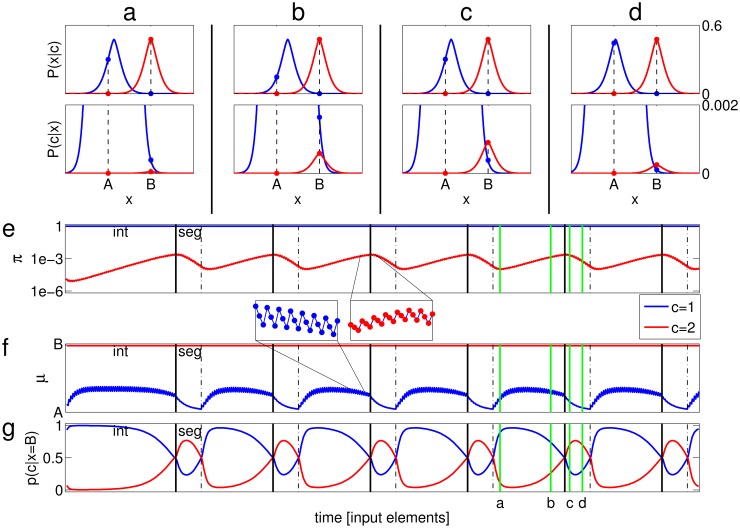
State of the mixture distribution in response to an ABA- sequence, shown at several time points.The top plot in each panel shows the conditional likelihood of the two classes, P(x|c = k) as a function of x, and the bottom shows the a-posteriori probability P(c = k|x), with the ordinate magnified so as to observe the relationship between P(c = 2|B) (red dot above B) and P(c = 1|B) (blue dot above B). (a) During integration (where both inputs are classified to class 1), μ1 approaches a value midway between A and B, causing a decrease in P(A|c = 1). (b) This decrease causes π2 to undergo a net increase. (c) The increase in π2 results in a switch to segregation: B is now classified to class 2. (d) μ1 returns towards A; the result is a net decrease in π2. (e-g) The dynamical variables as a function of time. Black vertical lines indicate switches from integration to segregation (solid) and vice versa (dashed), as indicated by the labels “int” and “seg” in the first two phases. Green vertical lines indicate the time points sampled at (a-d). (e) π1, π2, plotted in log scale. The inset illustrates the fast oscillations of π2, where each point indicates one time step; notice there are two down steps after each up step, because A occurs twice after every occurrence of B in the ABA- sequence. (f) μ1, μ2. The inset illustrates the fast oscillations of μ1. (g) The value of P(c = 1|B) and P(c = 2|B), which sum up to 1. In this simulation γ = 0.1, η = 0.5, the stimulus elements are Δ = 5 apart, and the shape of the conditional likelihood is generalized normal with β = 1.5 and a variance of 1.